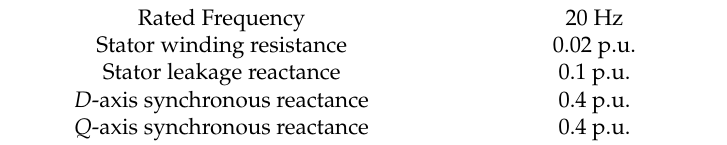
Figure 6. Pitch angle controller of the variable speed wind turbine. Table 5. Electrical parameters of the permanent magnet synchronous generator